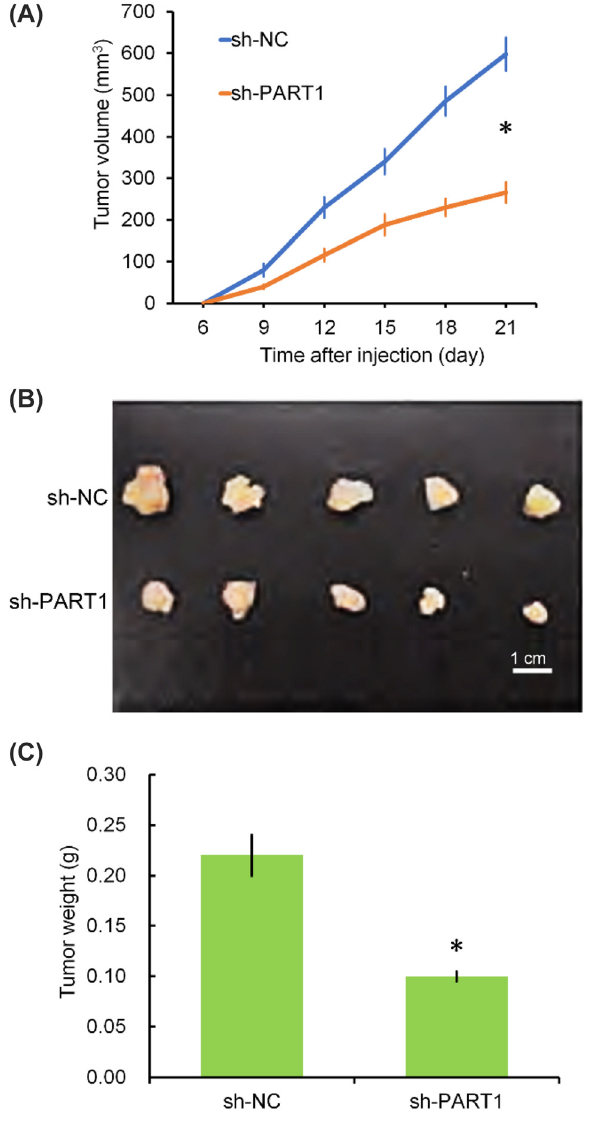
Figure 3: Downregulation of PART-1 reduced NSCLC tumour growth in vivo . Sh-PART1 and sh-NC cells were subcutaneously inoculated into nudemice(n=5pergroup)at1 × 107permouse.(A)Tumourvolumefrom 6to 21days afterinoculation.(B,C) Tumoursexcisedfrommiceat 21days afterinoculationandaveragetumourweight.*p<0.05sh-PART1groupvs. sh-NC